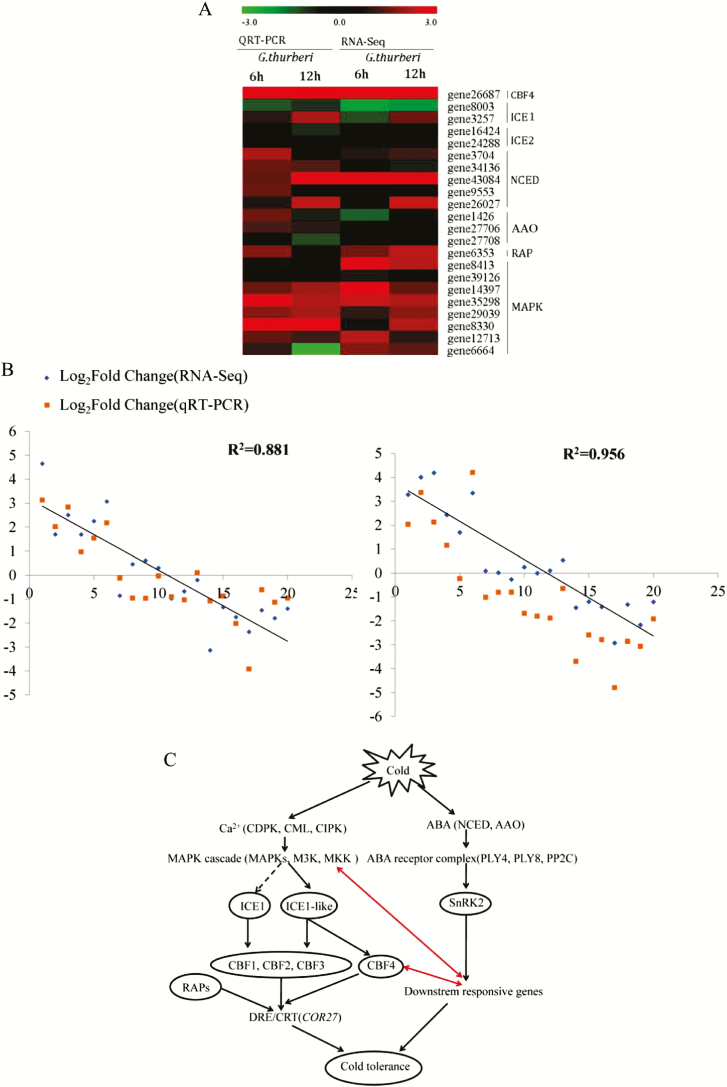
RT-qPCR validations of transcript levels evaluated by RNA-Seq in G. thurberi under cold stress for 6 and 12 h. (A) Heat map depicting log2 (fold change) of transcription factor; (B) regression analysis of the log2 (fold change) of RNA and qRT-PCR expression analysis of the DEGs; (C) a predicted model of cold response transcriptional network in G. thurberi. Red lines indicated the crosstalks between different signalling pathways predicted in this analysis. Y-axis—relative RNA-Seq expression levels and X-axis—relative RT-qPCR expression levels